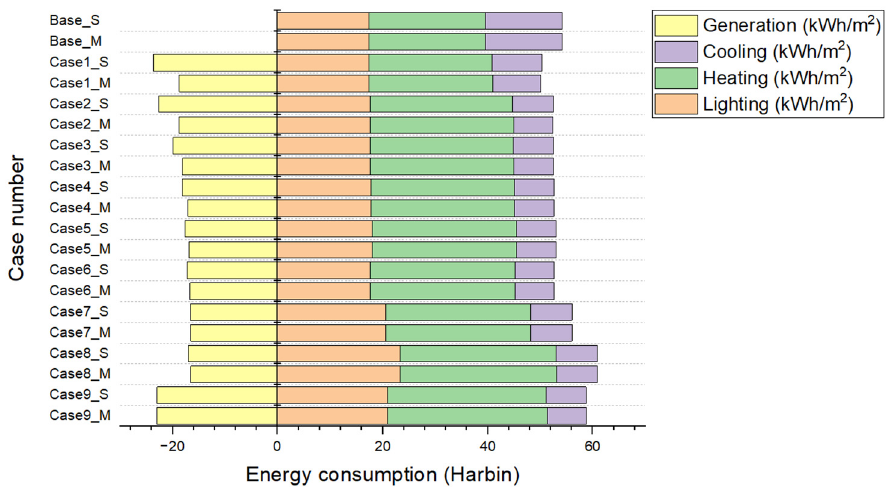
Figure 8. Energy consumption of single-story and multi-story buildings (in Harbin) with different PVSDs. ent